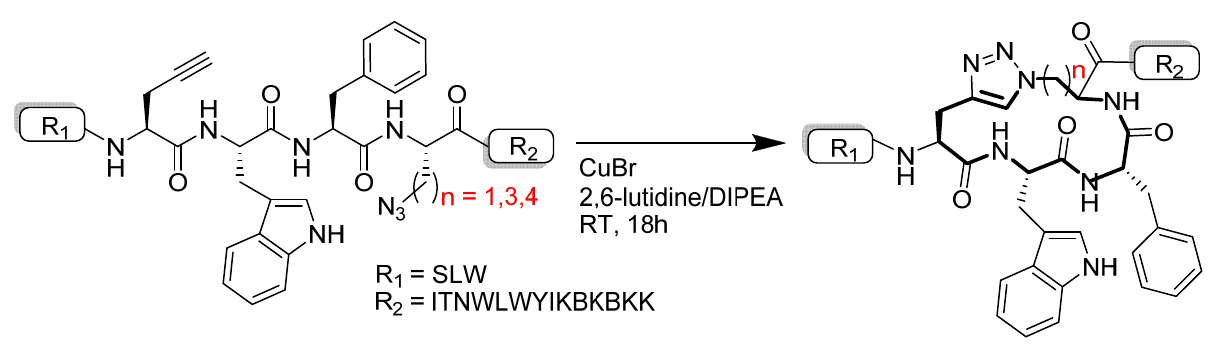
helix side-chain-to-side-chain CuAAC Figure 14. 3 10